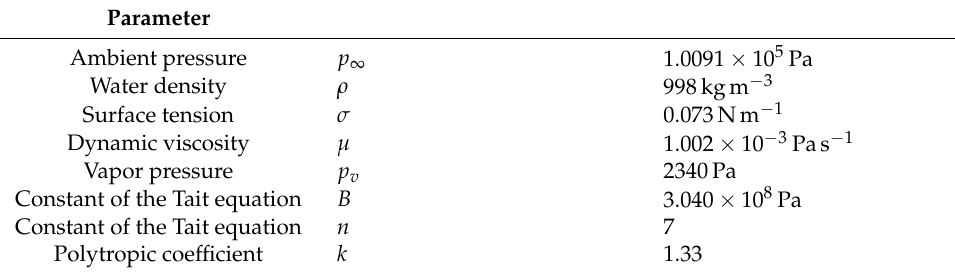
Table A1. Parameters used in the Gilmore model